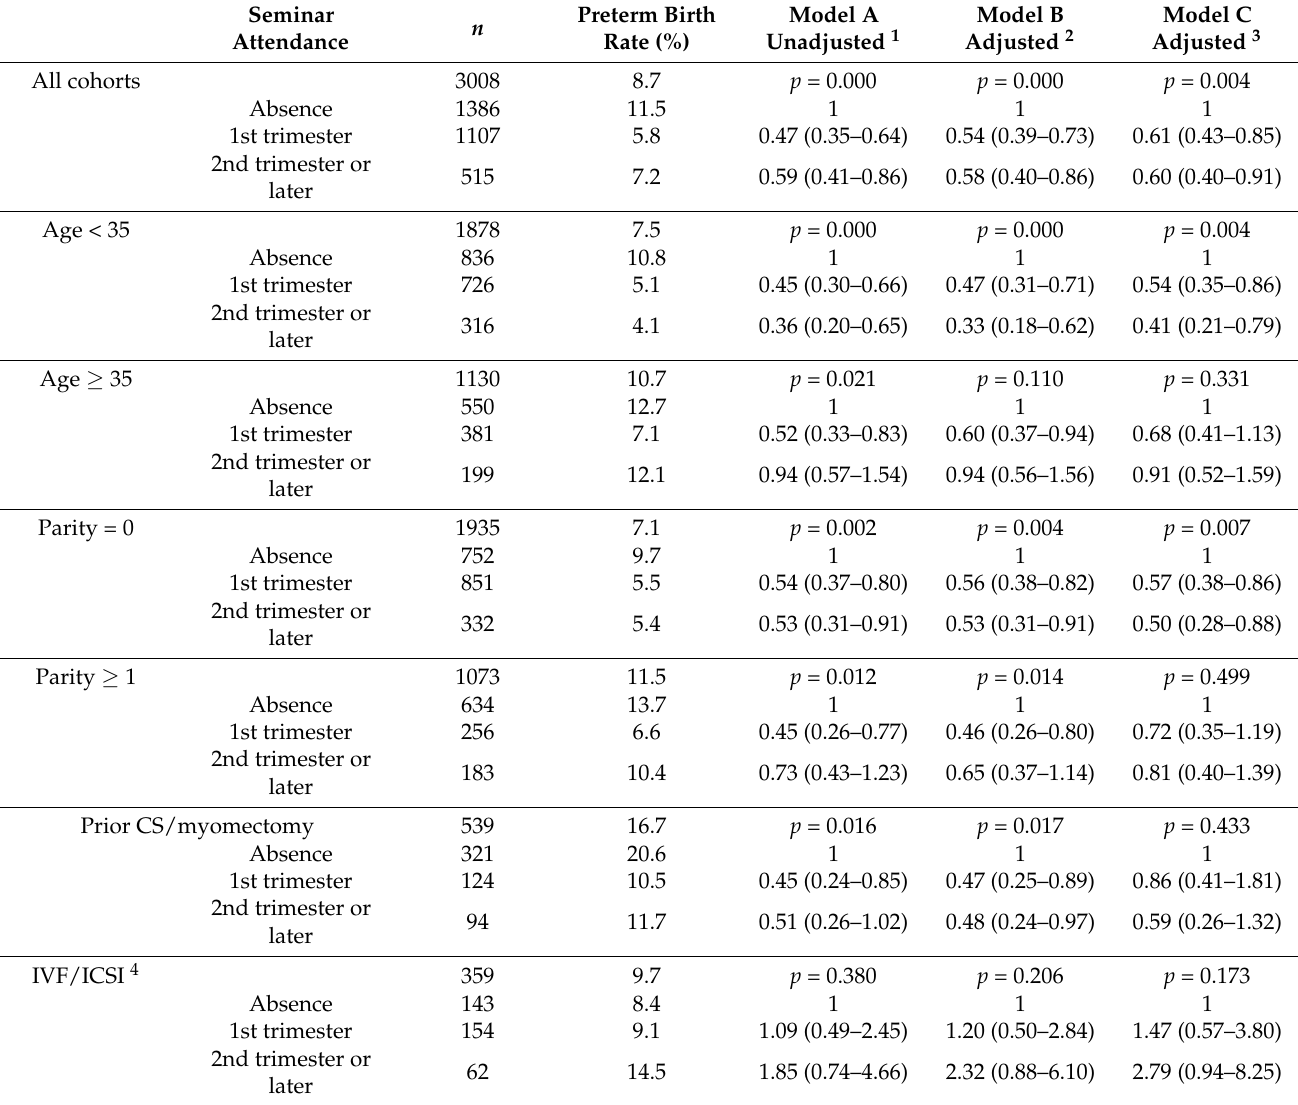
Table 3. Stepwise binary logistic regression of correlations between seminar attendance and preterm